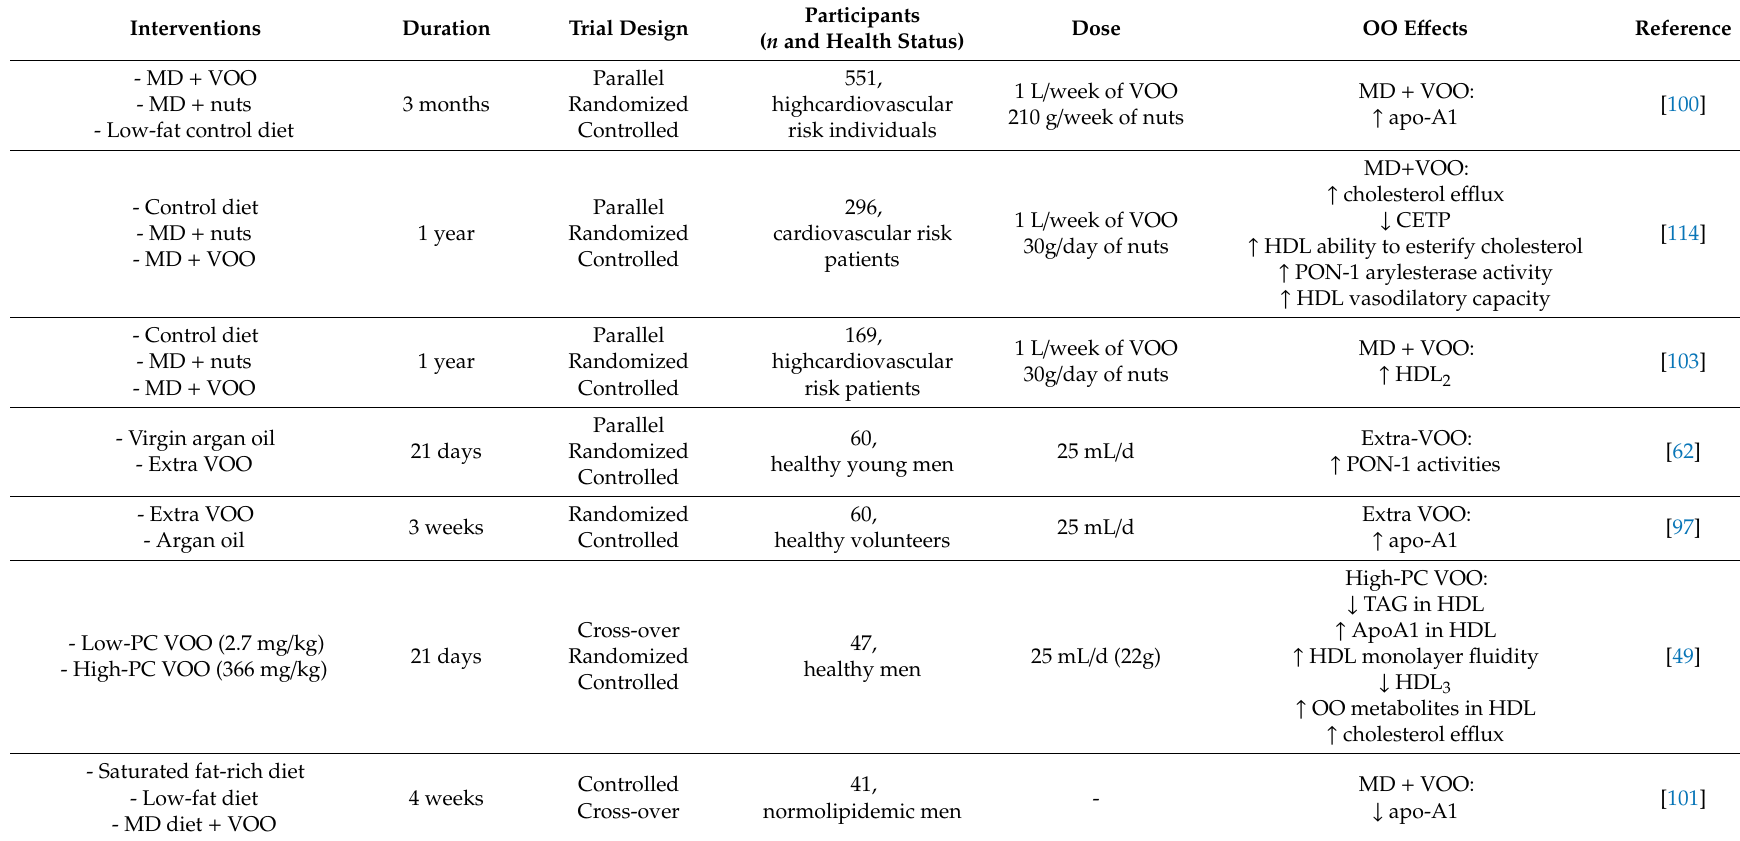
Table 4. Clinical trials which analysed the e ff ects of VOO and phenol-enriched VOO on HDL characteristics and